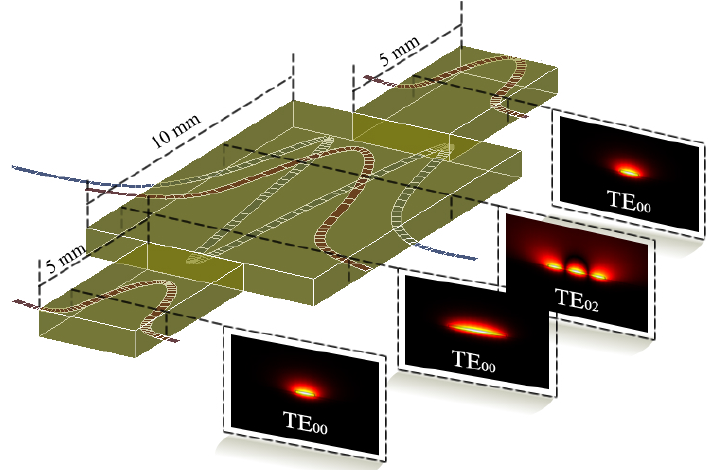
Figure 1. Scheme of the Trimodal waveguide sensor showing the expected light modes in each